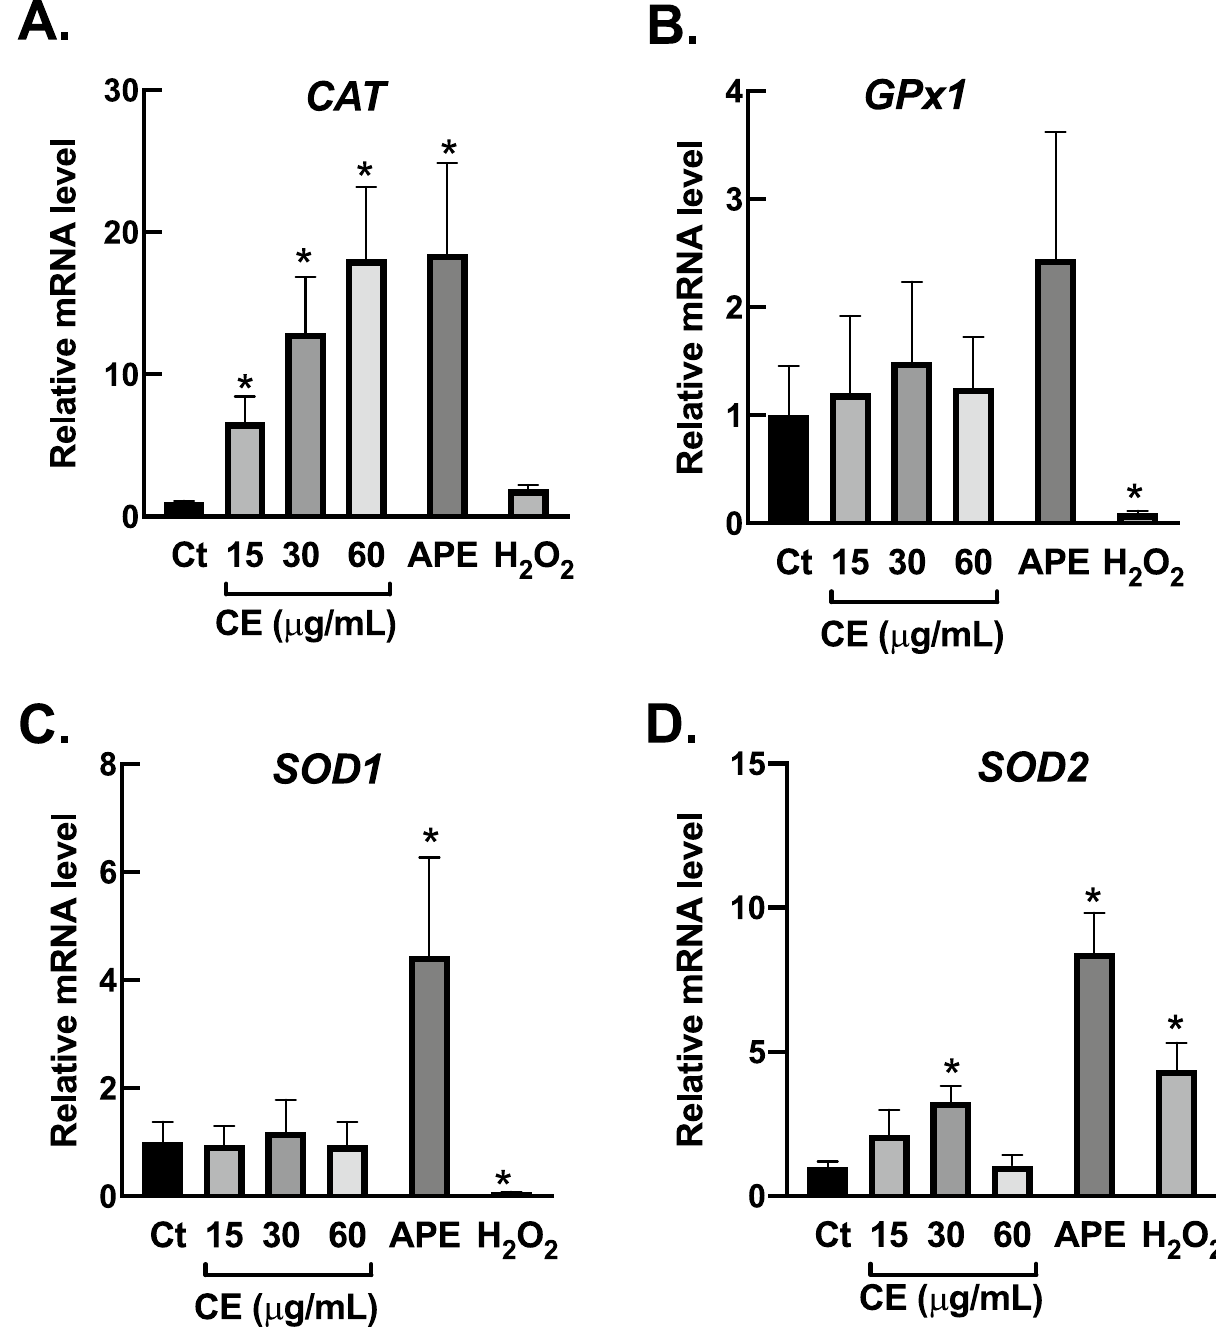
Figure 5. Centella extracts elevate transcription of antioxidant enzymes. ( A – D ) CE promoted CAT expression, while APE enhanced SOD1 and SOD2 expression. BJ cells were incubated with CE (15–60 µg/mL; 24 h) or APE (60 µg/mL; 24 h) or H 2 O 2 (200 µM; 1 h). The expressions of antioxidant machineries, including CAT , GPx1 , SOD1 , and SOD2 , were determined with RT-PCR following treatments ( n = 3; mean ± SEM; * P < 0.05 vs untreated